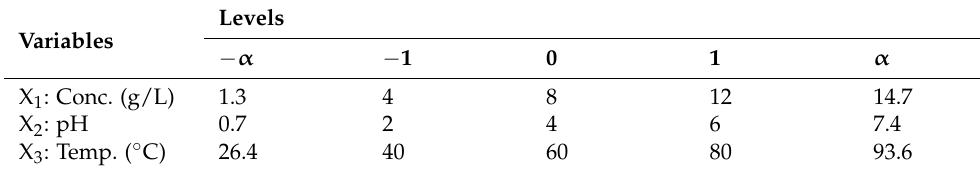
Table 1. Variables and experimental design levels.